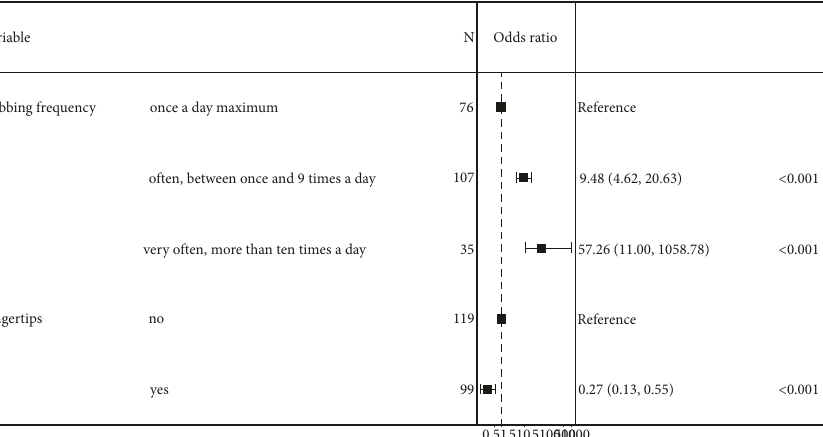
Figure 3: Forest plot of multivariate analysis of risk factors in the eye rubbing population. Graphical representation of the odds ratio of the risk factors of keratoconus in the eye rubbing population from the multivariate linear